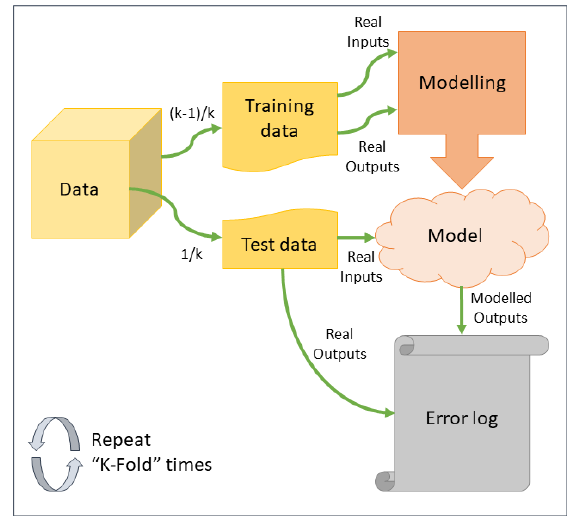
Figure 6. Cross validation using